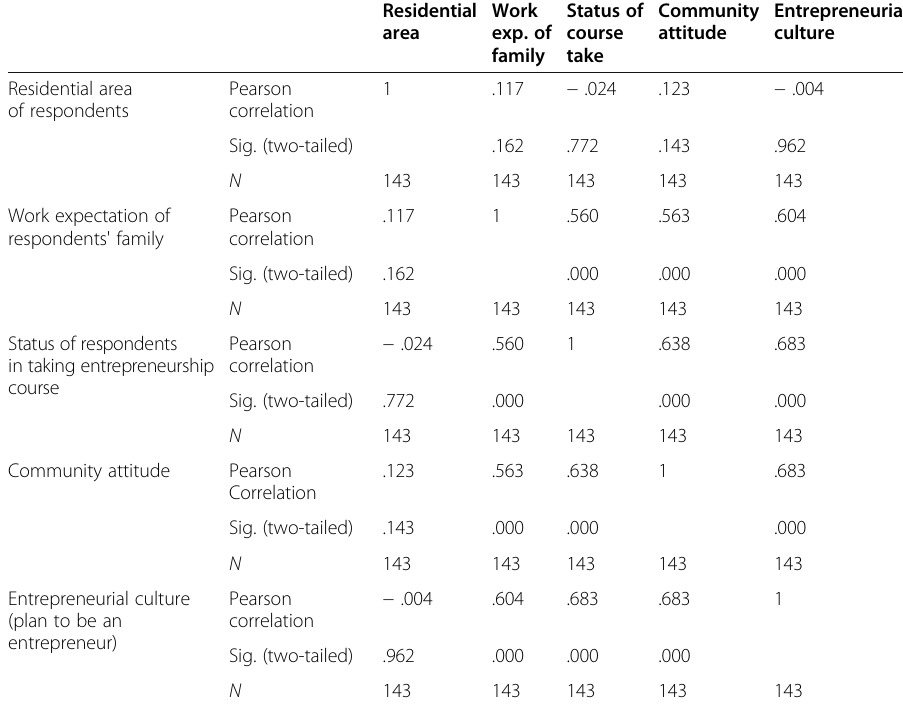
Table 1 Correlation